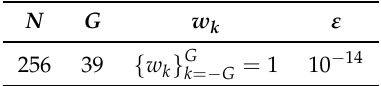
Table 3. Simulation parameters for the first example.